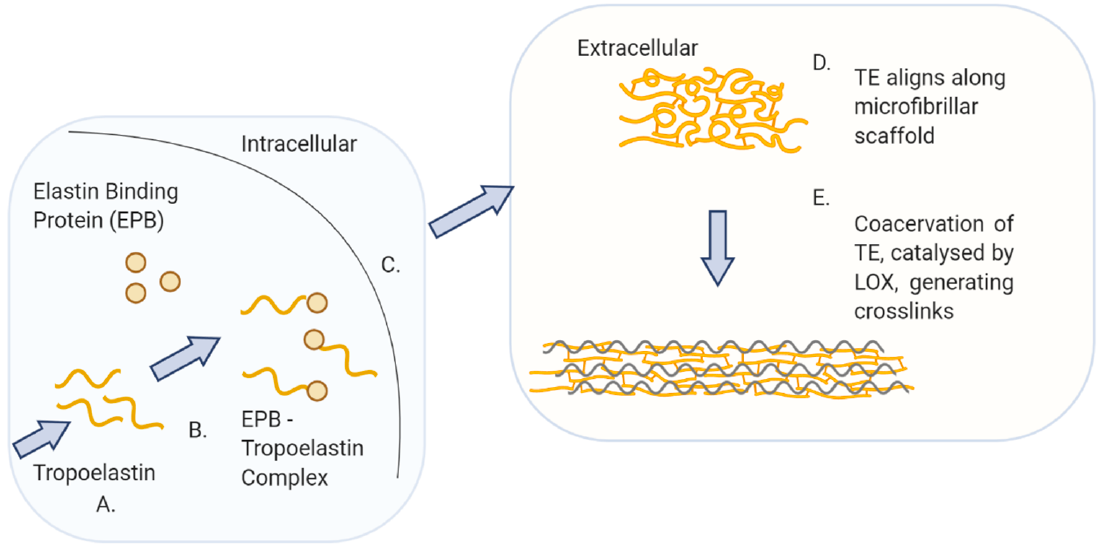
Figure 4. Elastin biosynthesis pathway: A. Tropoelastin (TE), precursor of elastin, is translated from mRNA in the rough endoplasmic reticulum. B. TE and elastin binding protein (EBP) form a complex in the Golgi apparatus. C. The TE–EBP complex is secreted to the extracellular space. D. The EBP detaches from TE, allowing TE to interact and align along the microfibrillar scaffold. E. Coacervation of TE together with the enzymatic reaction, catalysed by lysyl oxidase (LOX), result in the crosslinking of the TE molecules into the polymeric elastin fibre.